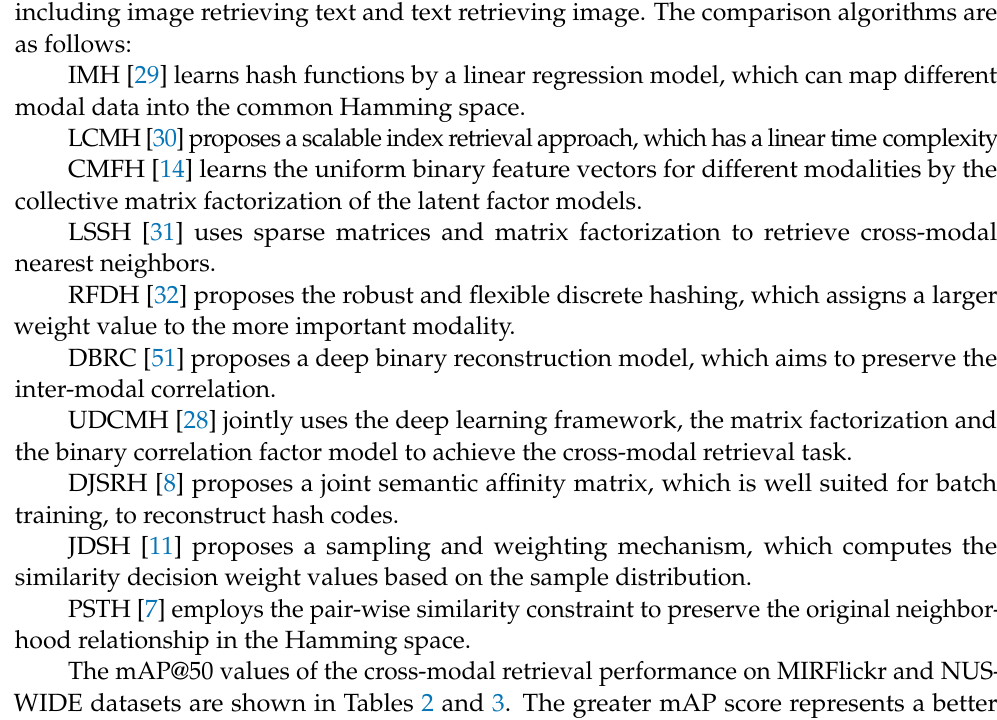
algorithm by the PyTorch V1.11.0 deep learning framework on an Ubuntu server